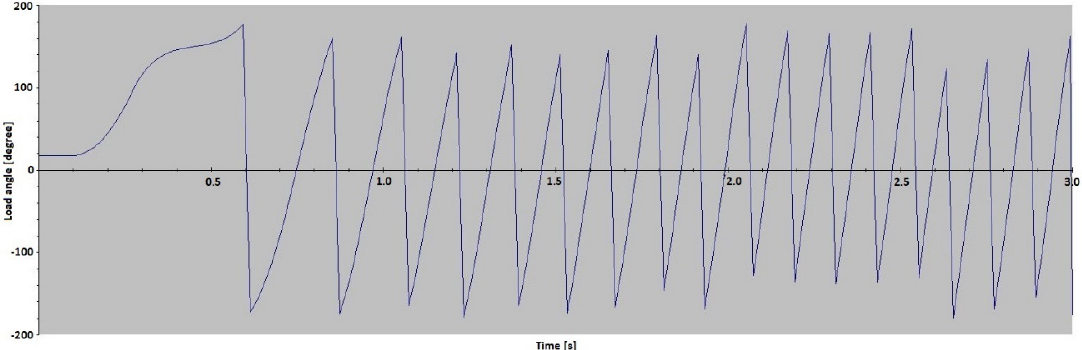
Figure 24. Simulation results of reactive power of Generator 2 during the three-phase fault with the fault duration of 172 ms.